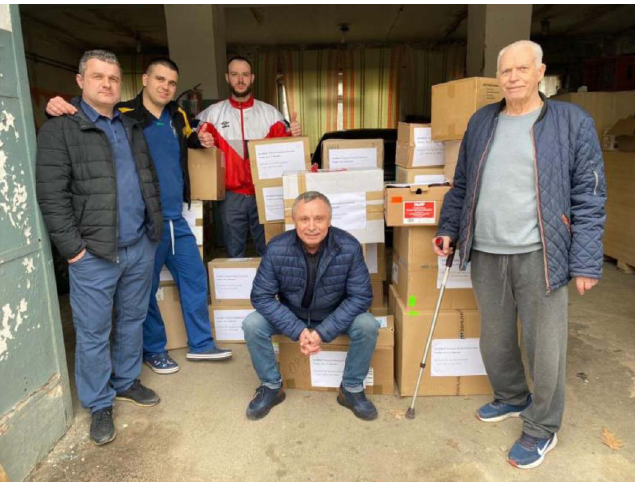
Figure 3. Handing over the medical equipment in Kharkiv, Ukraine. In the middle sitting Professor Dr. Igor A. Kryvoruchko, Kharkiv National Medical University, Kharkiv, Ukraine. From left to right: Vladimir S. Poltavets, Head Economic Service, Ivan G. Fursov, resident, Oleg V. Volchenko, resident, Professor Dr. Igor Kryvoruchko, Head of Department of Surgery, and Rostyslav M. Smachylo, Head of the Department of the Liver and Pancreas Surgery, Institute of General and Emergency Surgery, each Kharkiv University. In accordance to personal communication with Professor Dr. Igor A. Kryvoruchko, Kharkiv National Medical University, Kharkiv, Ukraine, each individual at the picture gave permission, that the picture is published.